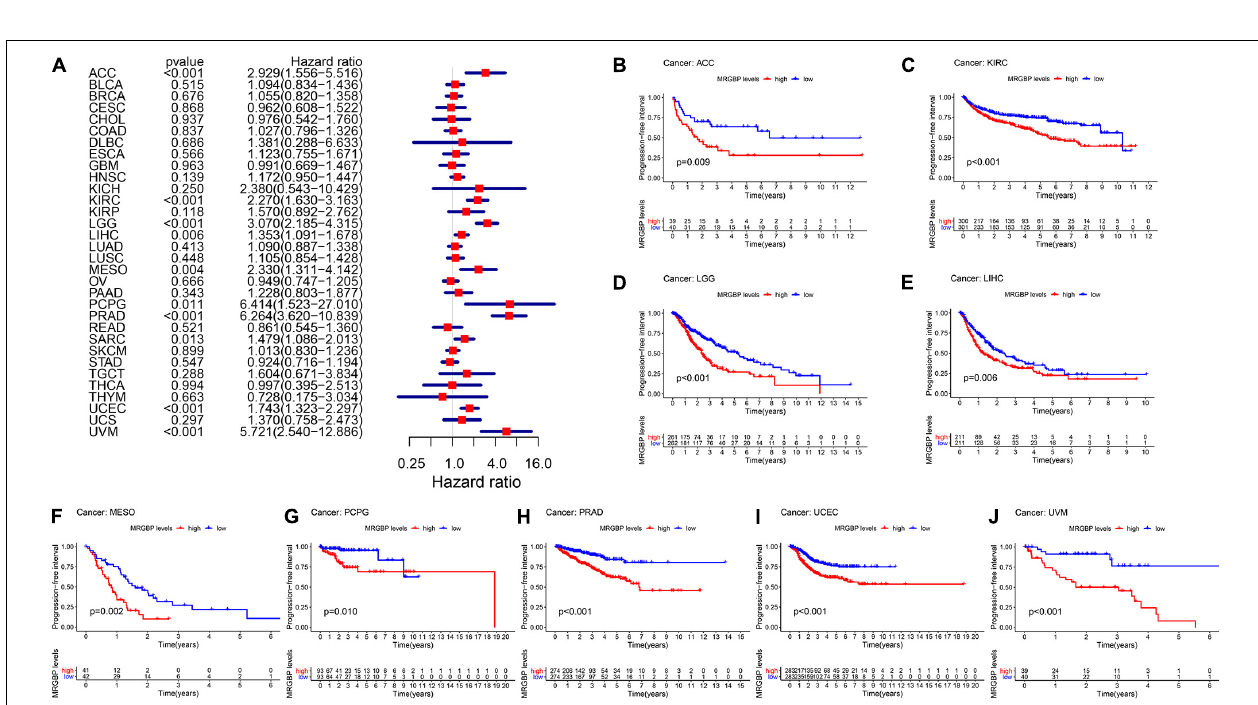
FIGURE 5 | Relationship between MRGBP expression and progression-free interval (PFI) in 33 tumors. The forest plots were calculated using univariate Cox regression (A) and the survival curves were calculated using Kaplan-Meier survival methods (B–J) .